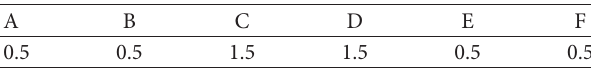
Table 3: Initial preset cracks of three-hole specimen with constant amplitude.